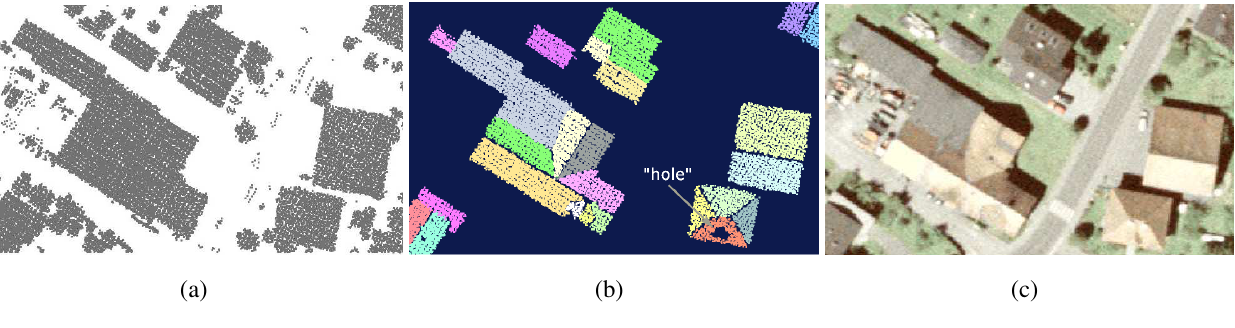
Figure 6. Roof face extraction, a) selected object points showing vegetation, roofs and other objects, b) roof points detected by region growing, c) orthophoto for comparison.